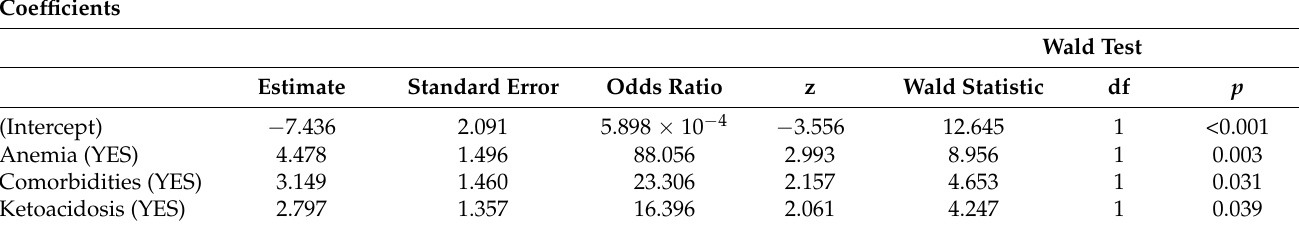
Table 4. Univariate logistic regression—Model Summary—Death.